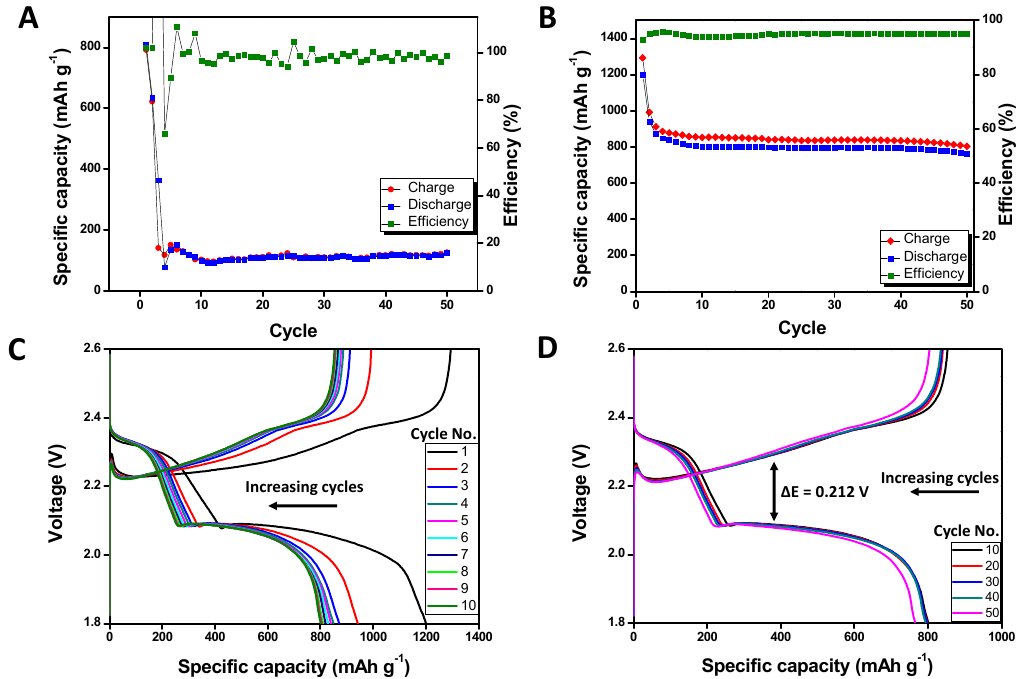
Figure 1. Electrochemical characterization of graphene-sulfur composites. ( A ) Cycling performance of graphene-sulfur composite GS1; ( B ) Cycling performance of graphene-sulfur composite GS2; ( C ) Charge/discharge curve of first 10 cycles of graphene-sulfur composite GS2; ( D ) Charge/discharge curve of 10, 20, 30, 40 and 50th cycles of graphene-sulfur composite GS2. All cycles were performed at a rate of C/10 (1C = 1672 mA·g − 1 ).